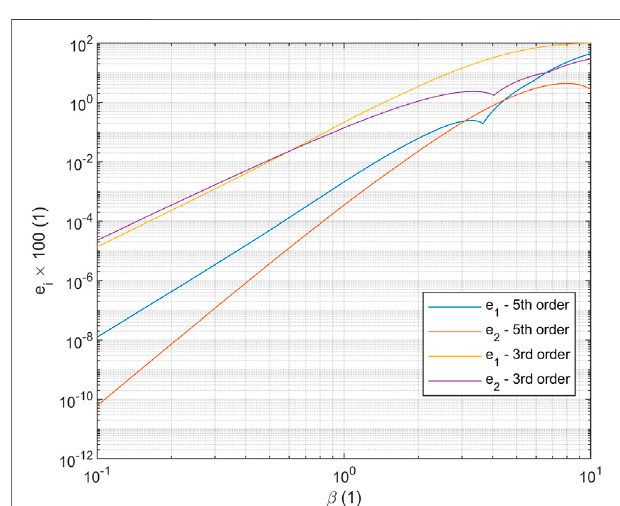
FIGURE 8 | Approximation errors for best polynomial fi ts in the L 2 norm to the solution for the linear beam on an elastic foundation problem. Higher- order polynomials permit greater elastic foundation